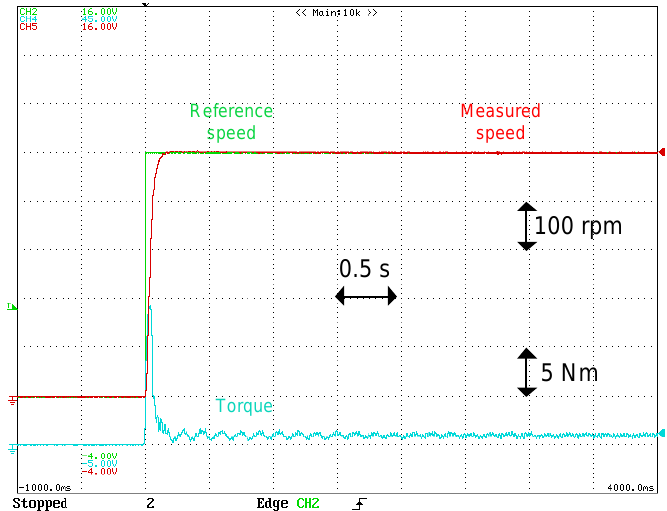
Figure 11. Experimental plots: speed and torque responses at the startup (0 to 500 rpm).